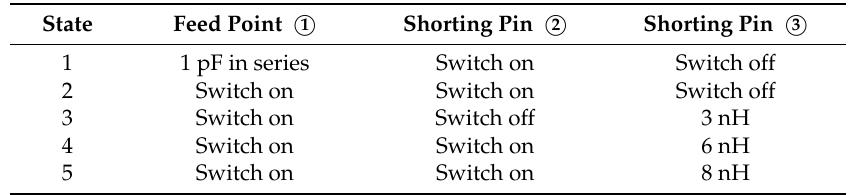
Figure 9. Five efficiency states of the proposed antenna: State 2 for lower bands and the other four states for mid and high bands. Table 2. Five states of the proposed antenna.